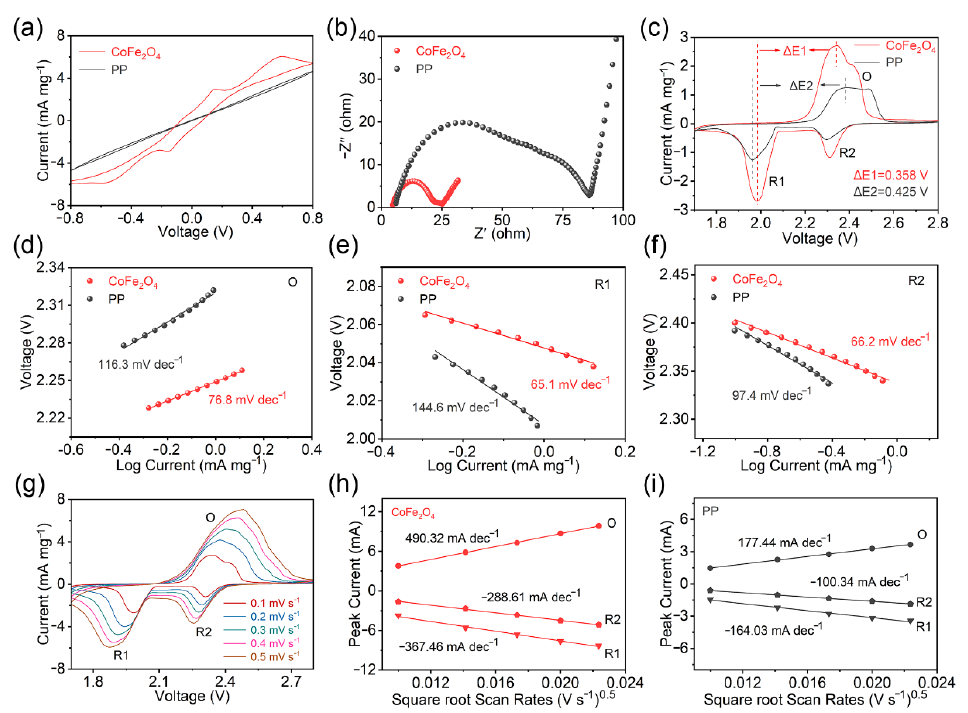
Figure 4. ( a ) CV and ( b ) EIS of symmetric cells with Li 2 S 6 additive; ( c ) CV curves of sulfur cathode with different separators; ( d – f ) the corresponding Tafel plots and fitted slope values of oxidation and reduction peaks; ( g ) CV curves with CoFe 2 O 4 -modified separator at various scan rates; ( h , i ) plots of the CV peak current versus the square root of the scan rates of lithium–sulfur batteries based on pure and CoFe 2 O 4 -modified separators. For Figure ( h ): the red circle represents the data points corresponding to the oxidation peak (O) in Figure ( g ), and the triangle and pentagon correspond to the data points of the first reduction peak (R1) and the second reduction peak (R2), respectively. For Figure ( i ): Figure ( i ) is a graph between the CV peak current of the lithium-sulfur battery based on the PP separator and the square root of the scan rate, so the upper left corner is marked with PP. The gray circle represents the data points corresponding to the oxidation peak (O) in Figure S4, and the triangle and pentagon correspond to the data points of the first reduction peak (R1) and the second reduction peak (R2),